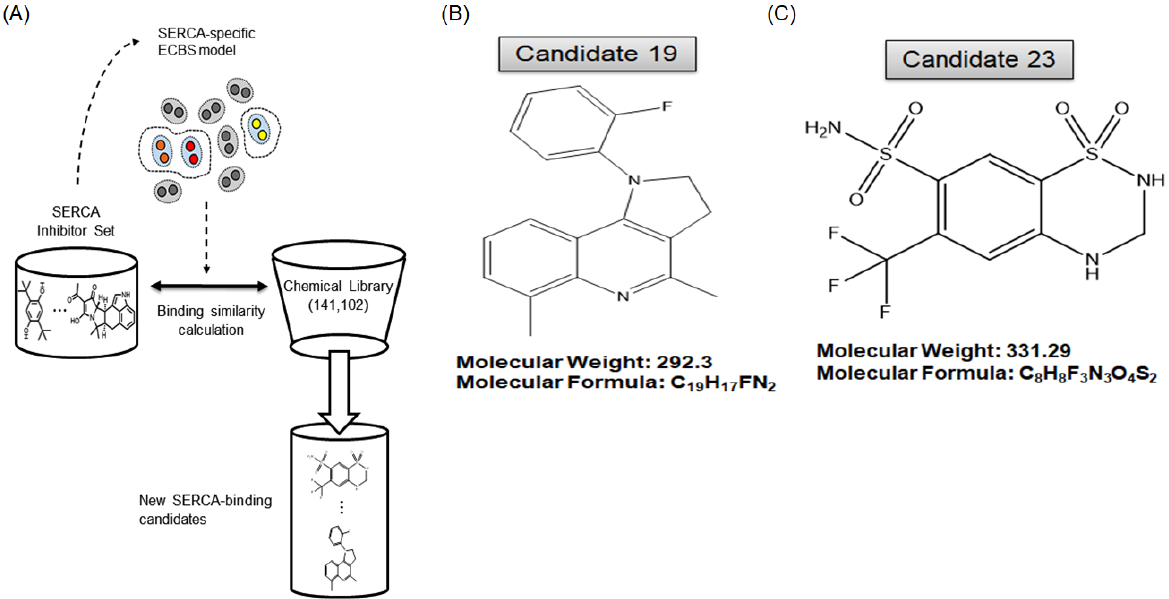
Figure 3. In silico screening using the evolutionary chemical binding similarity (ECBS) method for the discovery of SERCA inhibitors. ( A ) The general categorization of diverse ECBS models is presented with an example. ( B , C ) Chemical structures and information of candidates 19 and 23.